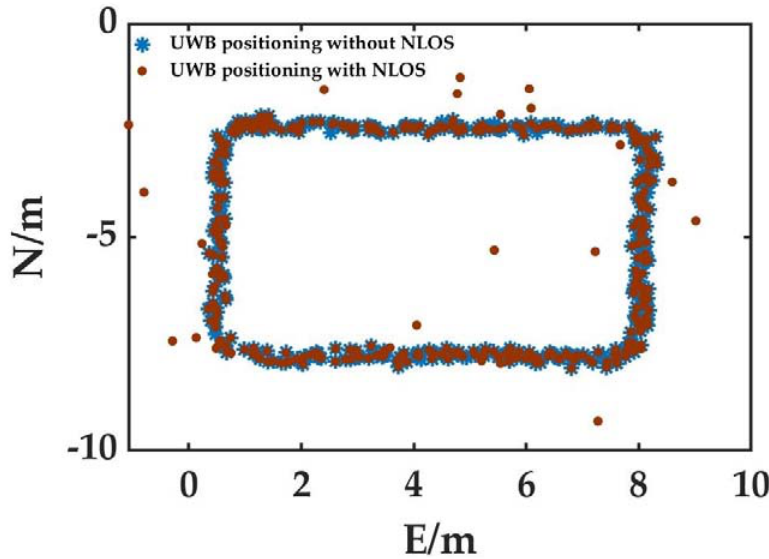
Figure 2. UWB simulation experiment results.